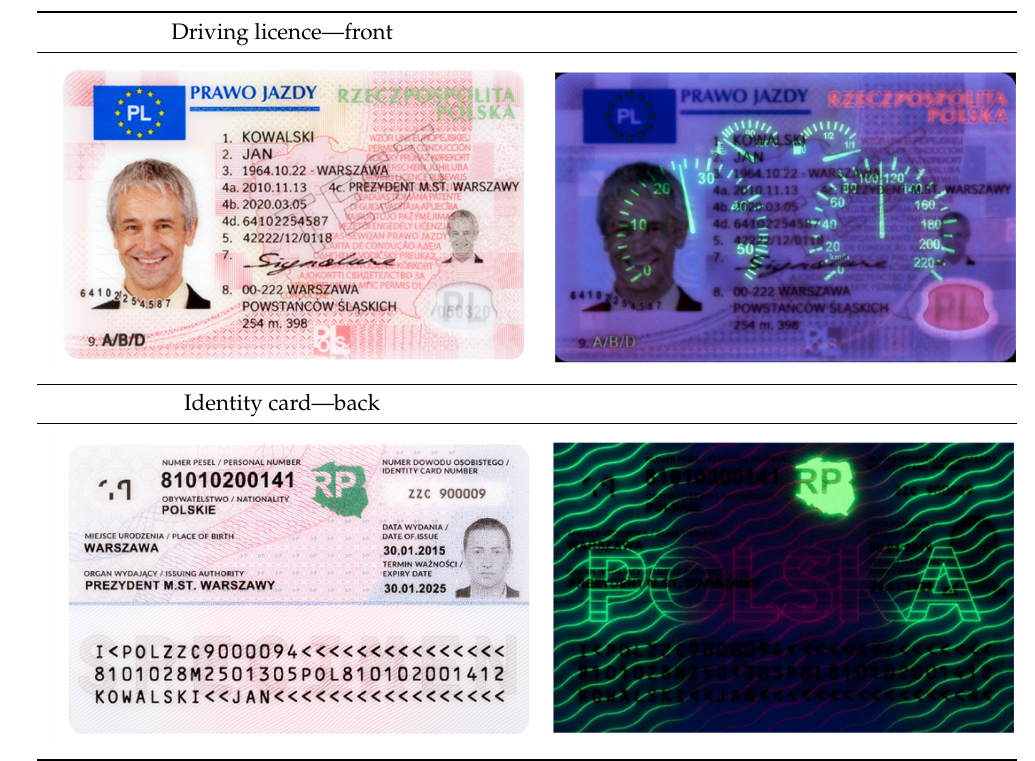
Table 1. Selected sample images used in the simulation experiments (not to scale)—ambient light images ( left ) and corresponding UV light images with revealed fluorescent markers ( right